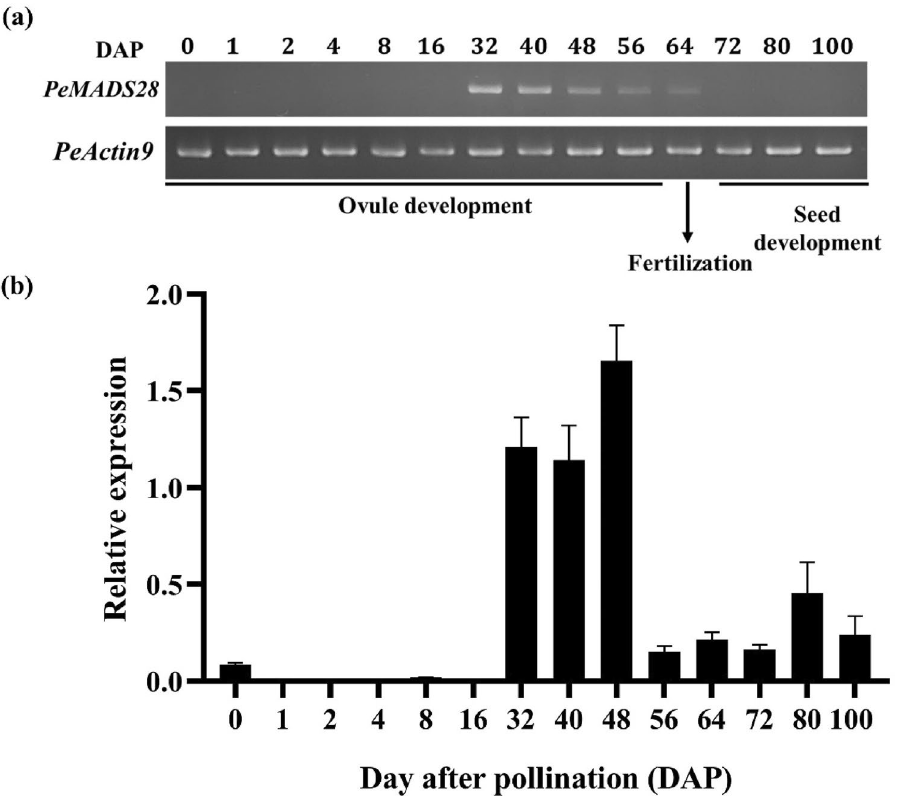
Figure 2. Expression patterns of PeMADS28 at various developing ovule stages in Phalaenopsis equestris ( a ) RT-PCR analysis of PeMADS28. Expression of Phalaenopsis actin was an internal control. ( b ) Quantitative real- time RT-PCR analysis of PeMADS28. DAP: days after